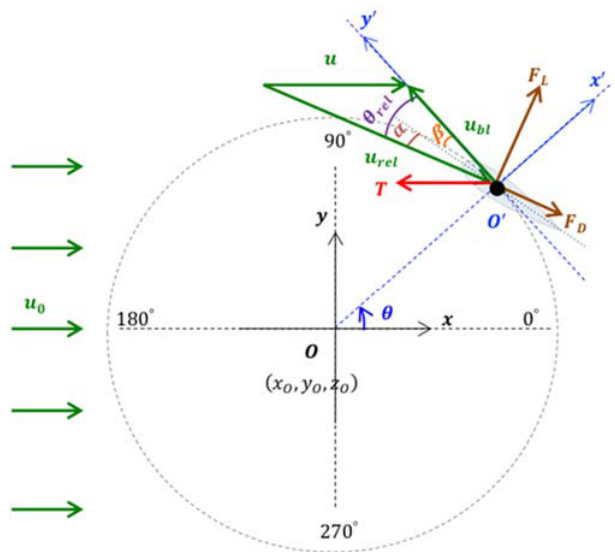
Figure 2. Geometry of and force vectors on a blade of a rotating vertical-axis turbine (VAT). The flow velocity relative to the blades is 𝑢 (cid:3045)(cid:3032)(cid:3039) (cid:4652)(cid:4652)(cid:4652)(cid:4652)(cid:4652)(cid:4652)(cid:4652)⃗ ; the angle of attack 𝛼 is calculated from the local inflow velocity 𝑢(cid:4652)⃗ ; the freestream velocity 𝑢 (cid:2868) (cid:4652)(cid:4652)(cid:4652)(cid:4652)⃗ ; and the blade velocity is 𝑢 (cid:3029)(cid:3039) (cid:4652)(cid:4652)(cid:4652)(cid:4652)(cid:4652)⃗ . The azimuthal blade angle is 𝜃 with the corrected blade pitch 𝛽 ; and 𝜃 (cid:3045)(cid:3032)(cid:3039) is relative angle. 𝐹 (cid:3013) and 𝐹 (cid:3005) are lift and drag forces per unit span respectively for the actuator line.